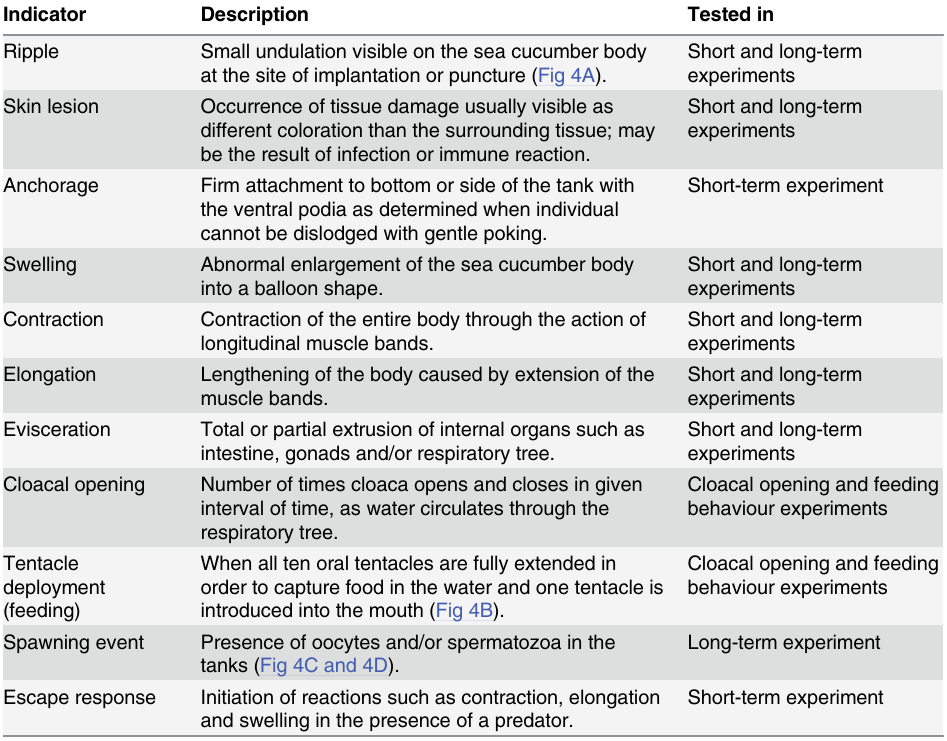
Table 2. Morphological, physiological and behavioural indicators of sea cucumber health monitored during the present study. Indicator Description Tested in Ripple Small undulation visible on the sea cucumber body at the site of implantation or puncture (Fig 4A). Skin lesion Occurrence of tissue damage usually visible as different coloration than the surrounding tissue; may be the result of infection or immune reaction.